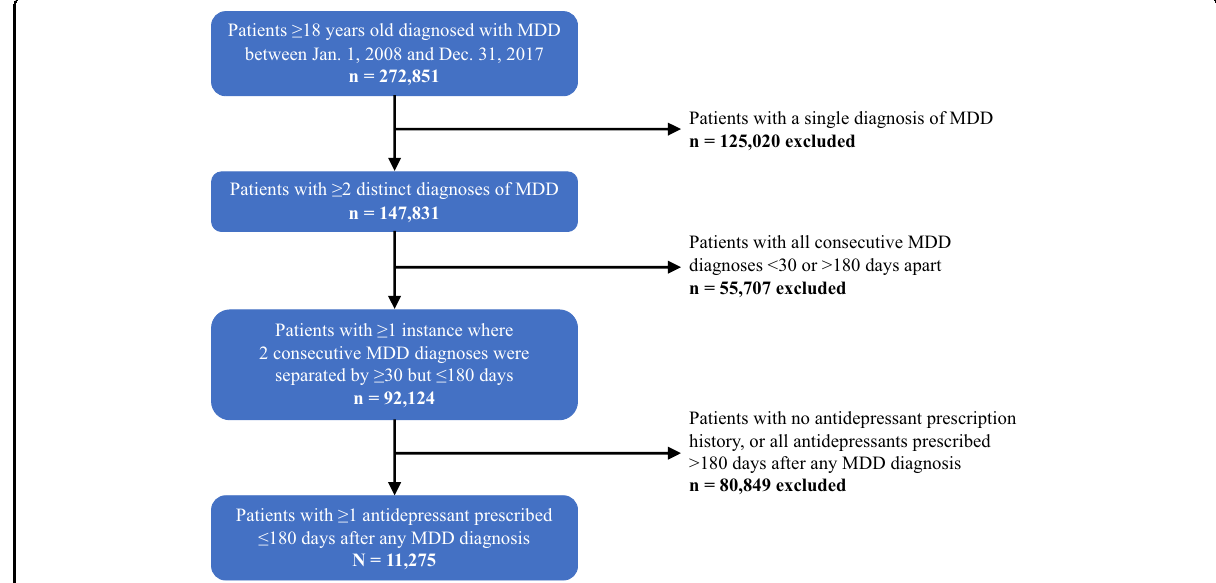
Fig. 1 Exclusion cascade used to select the MDD cohort from the INSIGHT CRN dataset. It should be noted that this study examines a niche group of patients with MDD who were treated via pharmacotherapy within a very narrow time window after diagnosis. Because (1) detection standards for depression are not well de fi ned, (2) documentation routines are highly variable particularly for patients with co-occurring SUDs, and (3) overlapping symptomatology makes it dif fi cult for practitioners to deduce a differential diagnosis, we opted to select a highly sensitive case de fi nition that greatly minimizes the inclusion of false positives and yields a sample of highly chronic patients 60 – 64 .